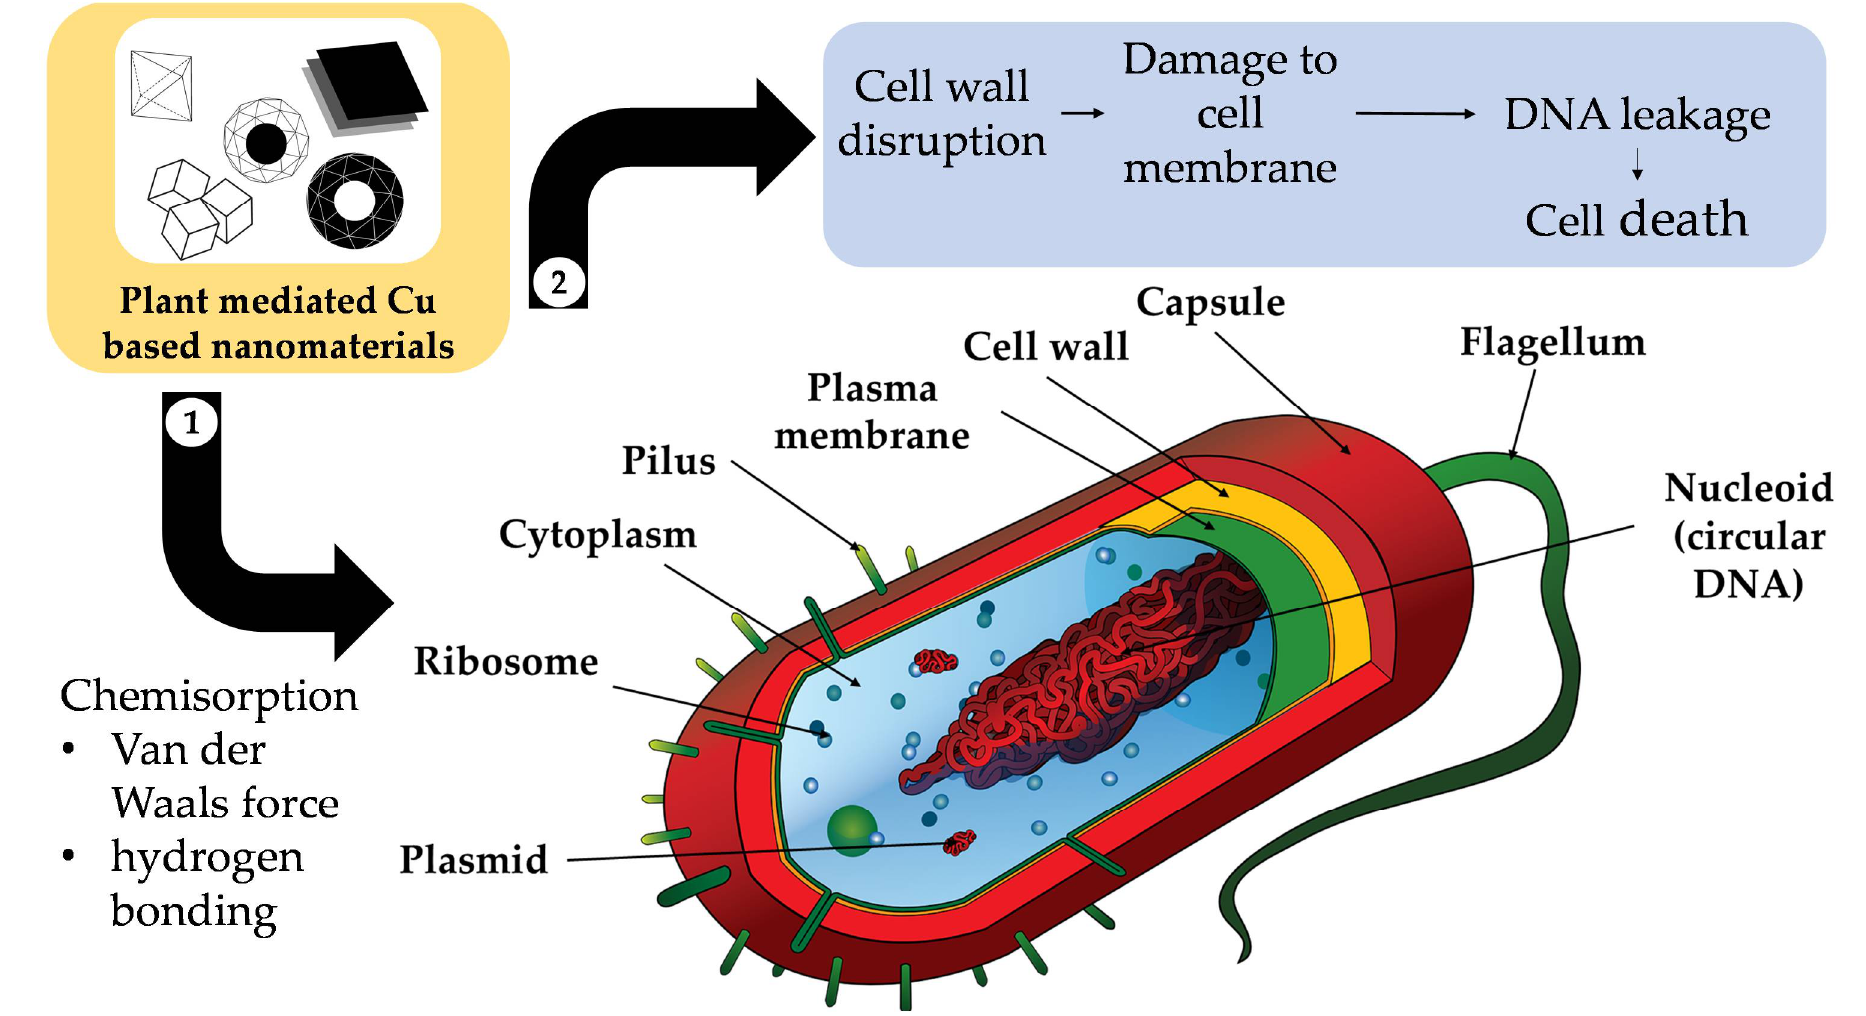
Figure 5. Diagram of the chemisorption-based mechanism of Cu-based nanomaterials’ antimicrobial activity.